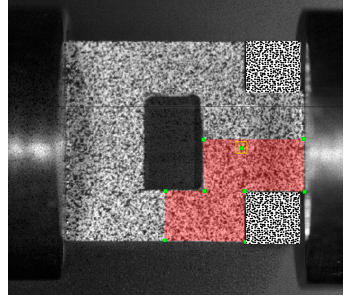
Figure 5. Diagram of speckle computing area.